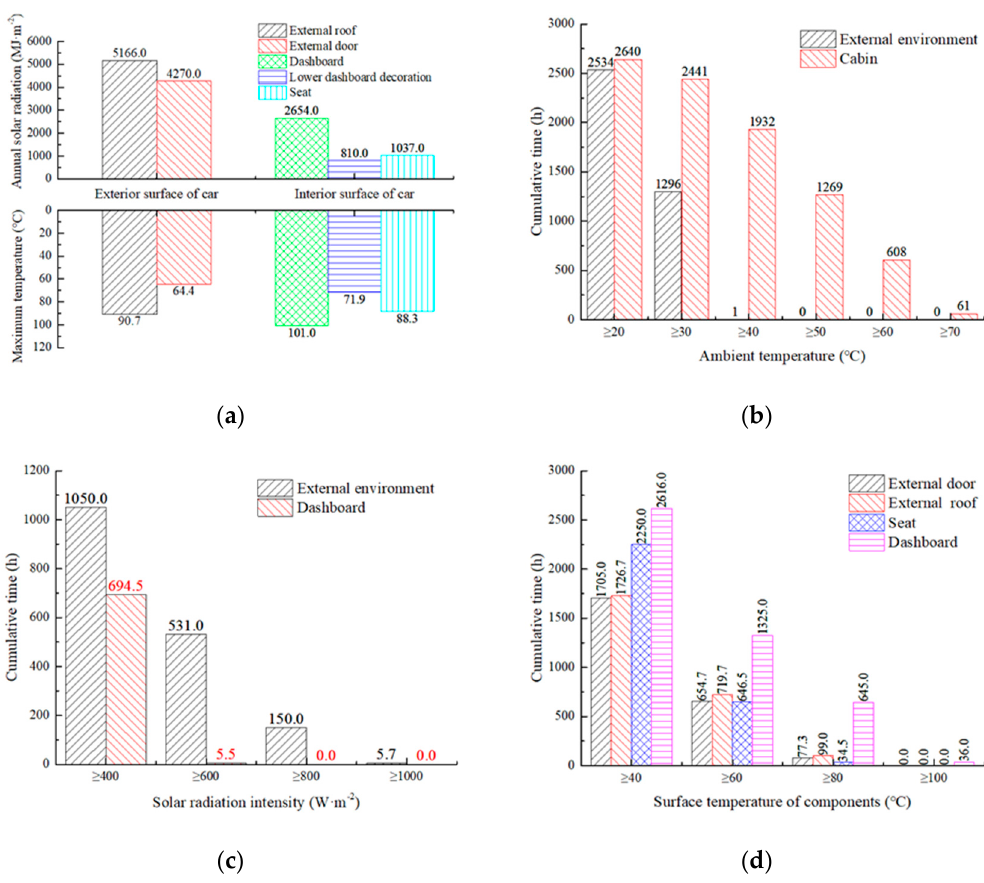
Figure 3. Annual statistical overview of the weathering external factors distribution inside and outside the automobile in non-uniform thermal environment: ( a ) annual radiation and maximum temperature of parts; ( b ) ambient air temperature and cumulative time; ( c ) solar radiation intensity and cumulative time; and ( d ) surface temperature and accumulated time of parts. Table 2. Environmental parameters at partial